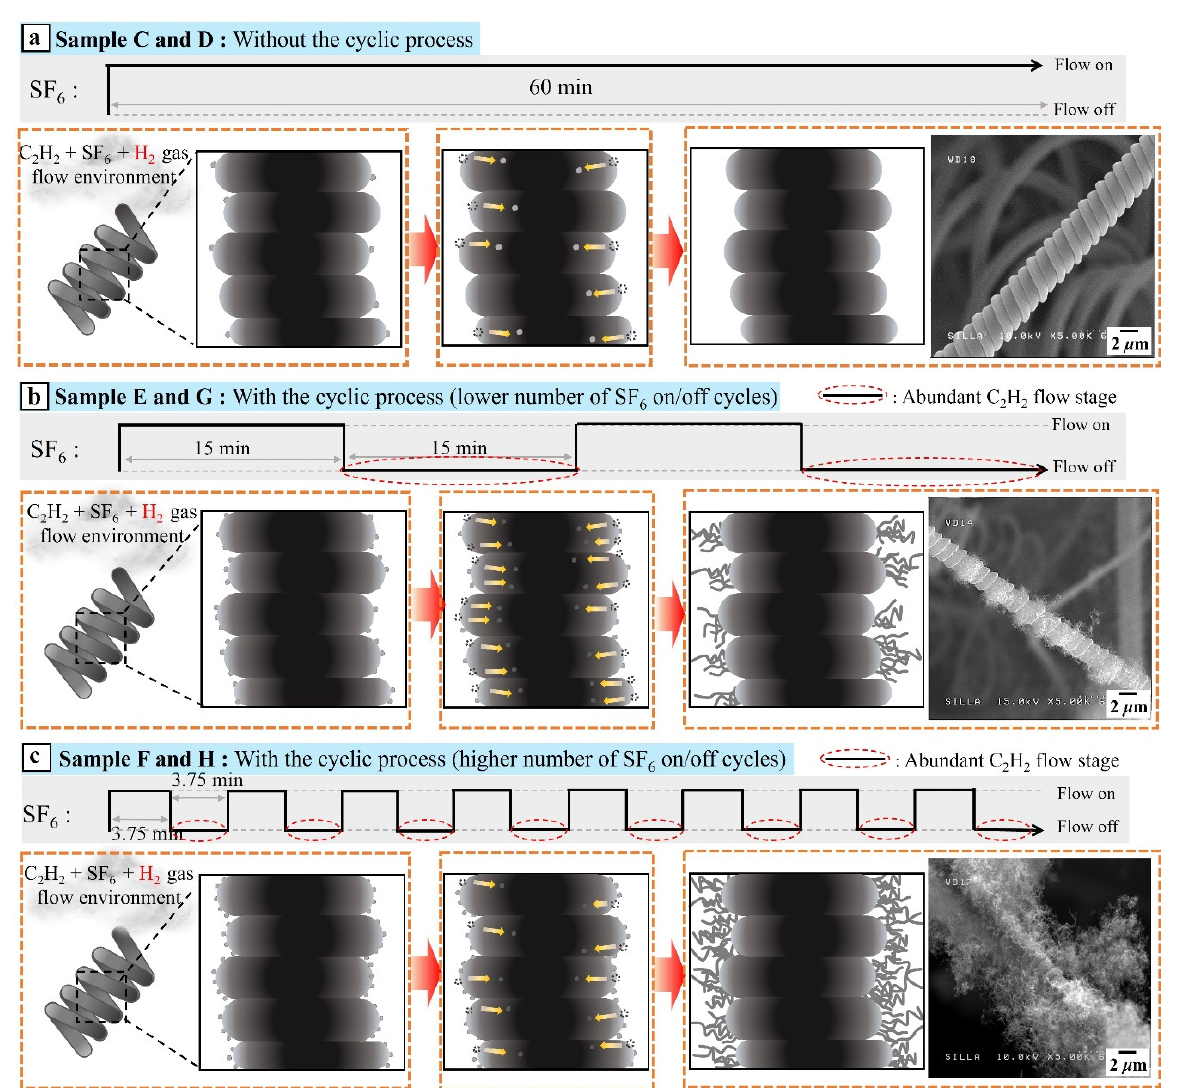
Figure 10. Systematic diagrams of the C 2 H 2 + SF 6 + H 2 gas flow system revealing ( a ) the selective formation of the numerous tiny CNFs only on i-CFs and not on CMCs without the cyclic process, ( b ) the nonselective formation of numerous tiny CNFs caused by the cyclic process, and ( c ) the increase in the number of tiny CNFs on CMCs with increasing frequency of on/off SF 6 flow cycles. Table 2. Thickness, volume resistivity, and electrical conductivity of samples A, B, D, G, and H. Samples